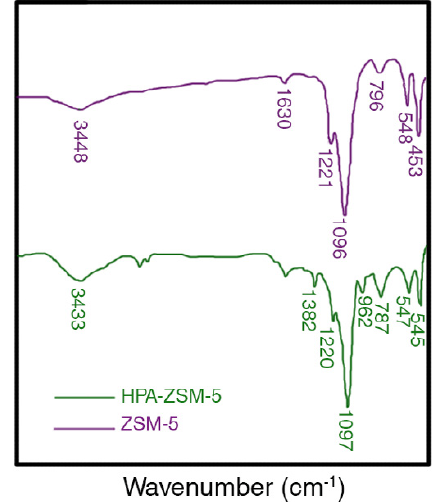
Fig. 5. Fourier-transform infrared spectroscopy spectra of ZSM-5, HPA-ZSM-5 Figure 5 . Fourier-transform infrared spectroscopy spectra of ZSM-5, HPA-ZSM-5 Table 1: Optimization of reaction conditions a Table 1: Optimization of reaction conditions